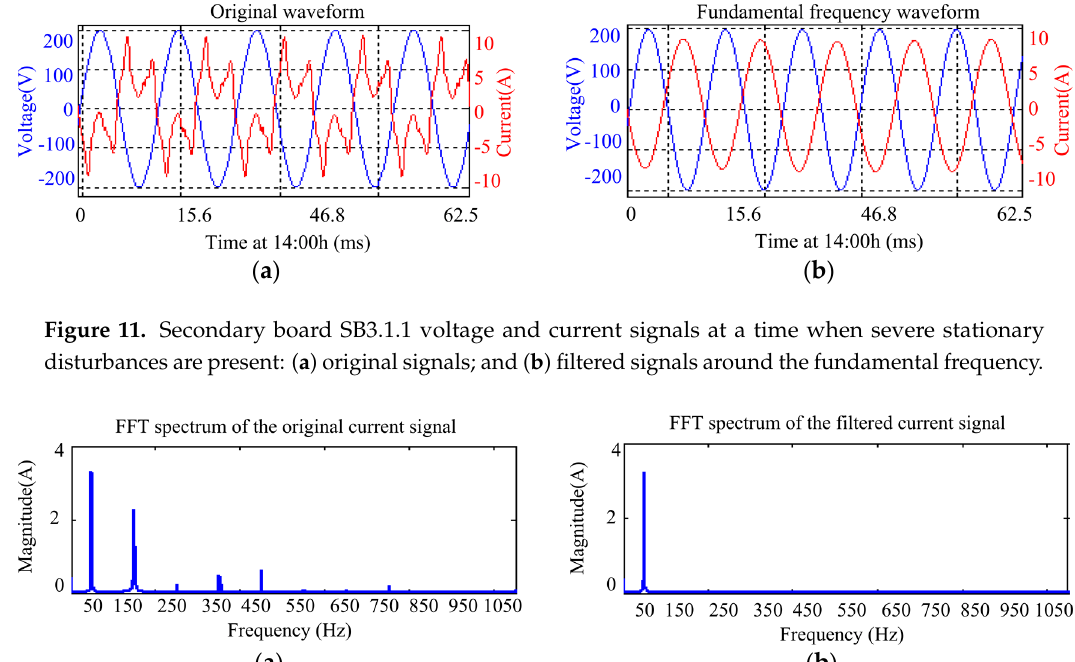
( b ) Figure 9. Main board MBD3 voltage and current signals at a time when stationary disturbances are present: ( a ) original signals; and ( b ) filtered signals around the fundamental frequency. ( a ) ( b ) Figure 10. Main board MBD3 FFT spectrum at a time when stationary disturbances are present: ( a ) original current signal spectrum; and ( b ) filtered current signal around the fundamental frequency. For the secondary board SB3.1.1, Figure 11a shows the presence of severe stationary PQD in the original current signal waveform during the hour 14:00. Figure 11b depicts the voltage and current